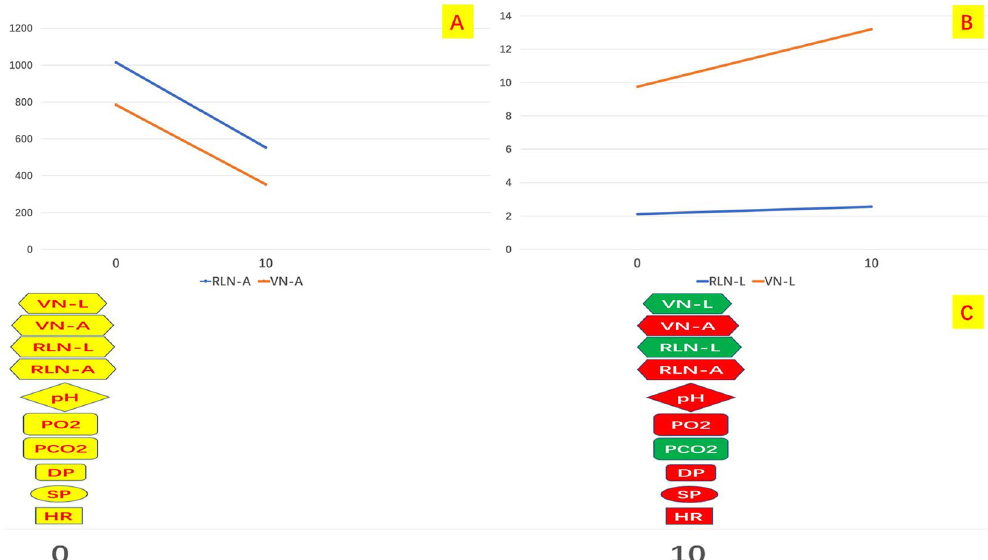
Figure 10. Group IV EMG profiles during experiment. Time trends for ( A ) amplitude values; ( B ) latency; ( C ) metabolic, hemodynamic and EMG parameters variations. Green dots: increase values. Red dots: decrease values. VN: vagal nerve. RLN: recurrent laryngeal nerve. L: latency. A: amplitude. PO 2 : PO 2 partial pressure. PCO 2 : CO 2 partial pressure. DP: diastolic pressure. SP: systolic pressure. HR: heart